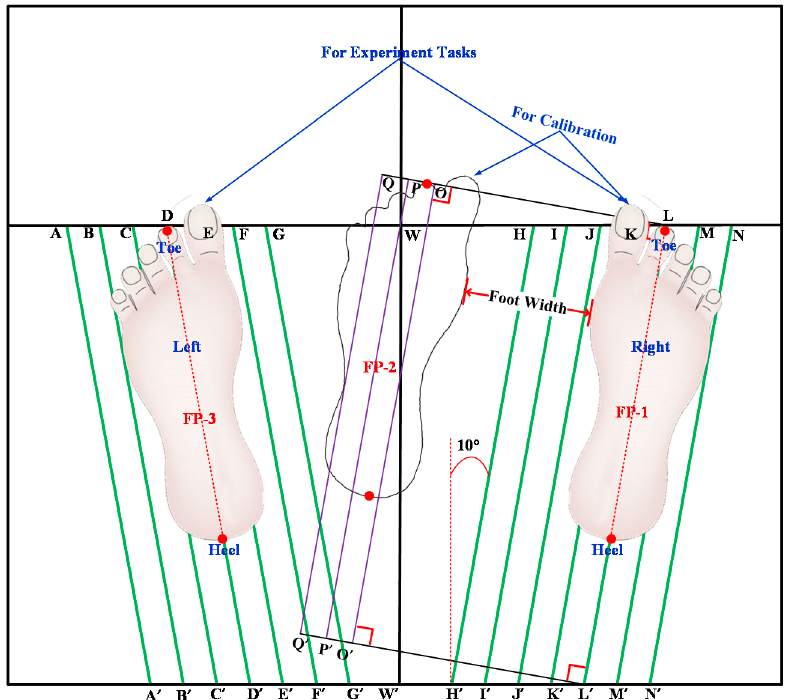
Figure 1. Paper for footprint acquisition and related foot positions.